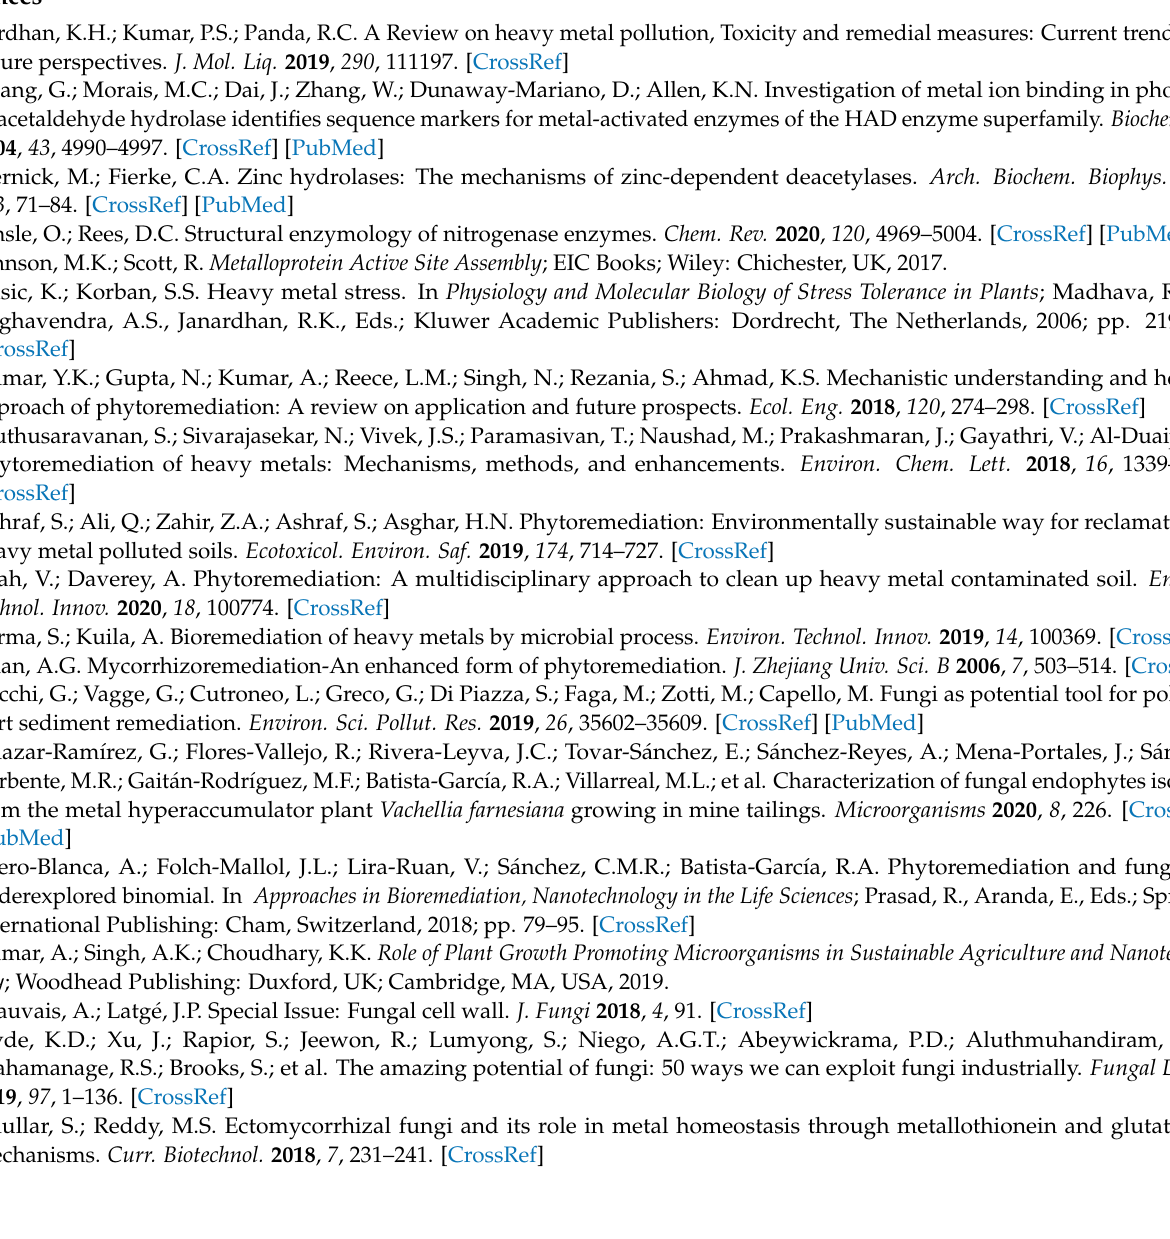
Table S4. Simple regression analysis between exposure time and heavy metal bioaccumulation in root and leaf of Prosopis laevigata growing under greenhouse conditions. The bold letters denote significant